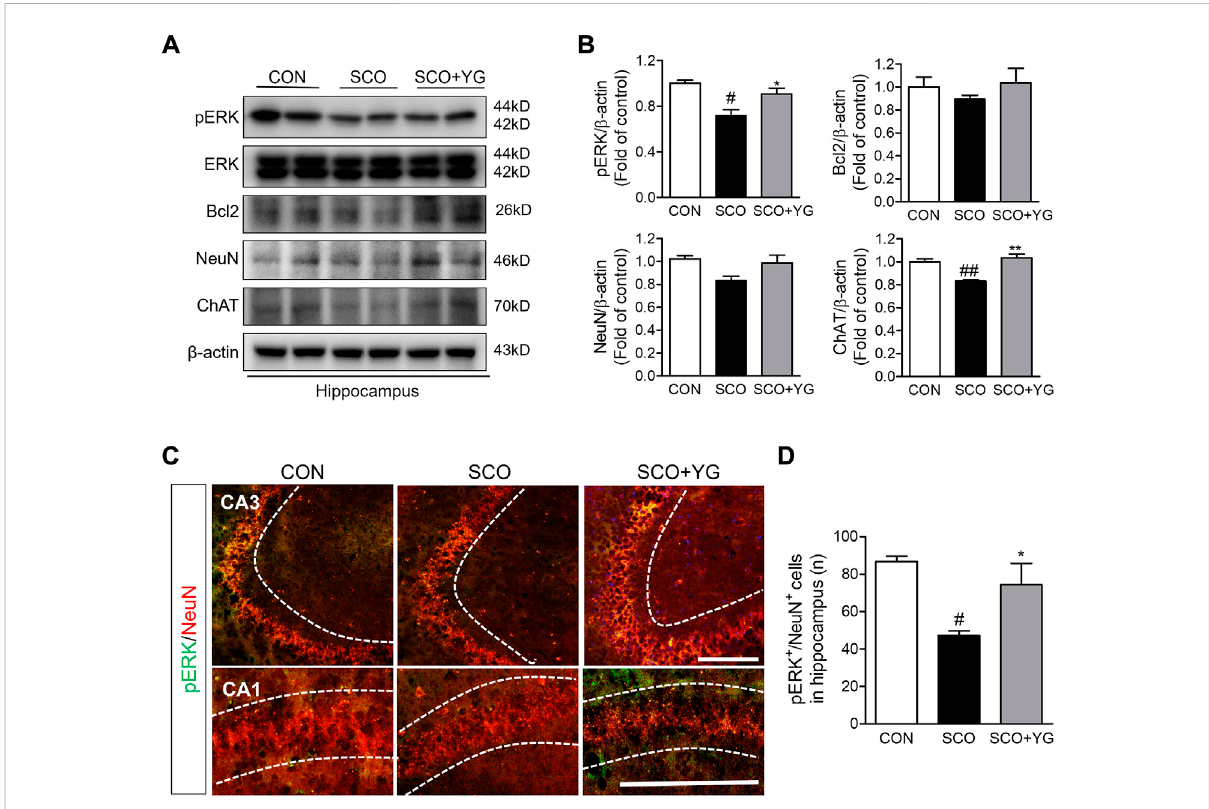
FIGURE 7 Effects of YG on ERK signaling-related protein expression in hippocampus of mice. (A) Western blot and (B) its histogram for Bcl2, ChAT, NeuN and pERK. Histograms show protein relative to β -actin protein. Double-immunostaining of pERK and NeuN in hippocampus of mice. (C) Microphotographsand (D) histogramforpERKandNeuNintheCA1and3regions.Alldataarepresentedasthemean±SEMfromthreeindependent mice. # p < 0.05, ## p < 0.01,vs.CON;* p < 0.05,** p < 0.01vs.SCObyANOVAwithNewman-keulspost-hocanalysis.Scalebar=200 μ m.CON; control, SCO; scopolamine, SCO + YG; scopolamine + Yuk-Gunja-tang 150 mg/kg, CA1; cornu ammonis1, CA3; cornu